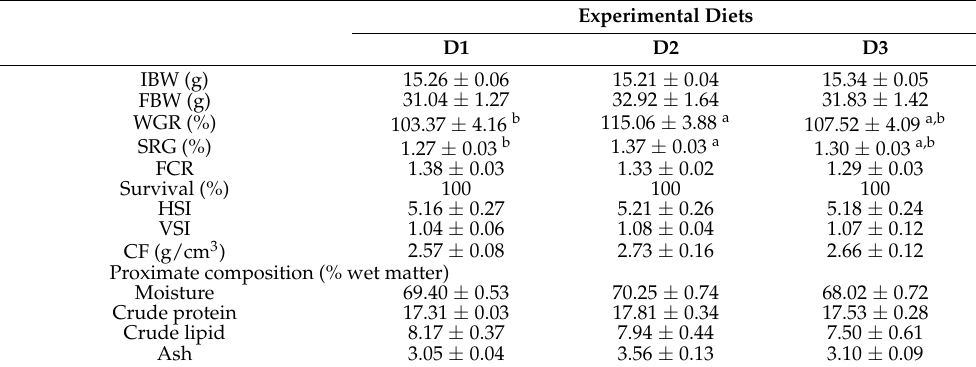
Table 2. Growth, feed conversion rate, and proximate composition of common carp with different dietary treatments after 8